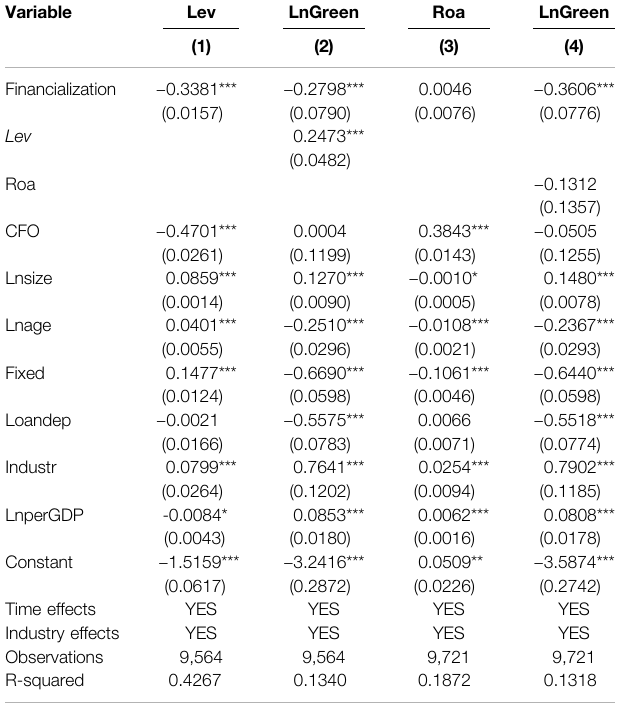
TABLE 4 | Estimation results of the impact of corporate fi nancialization on green technology innovation.